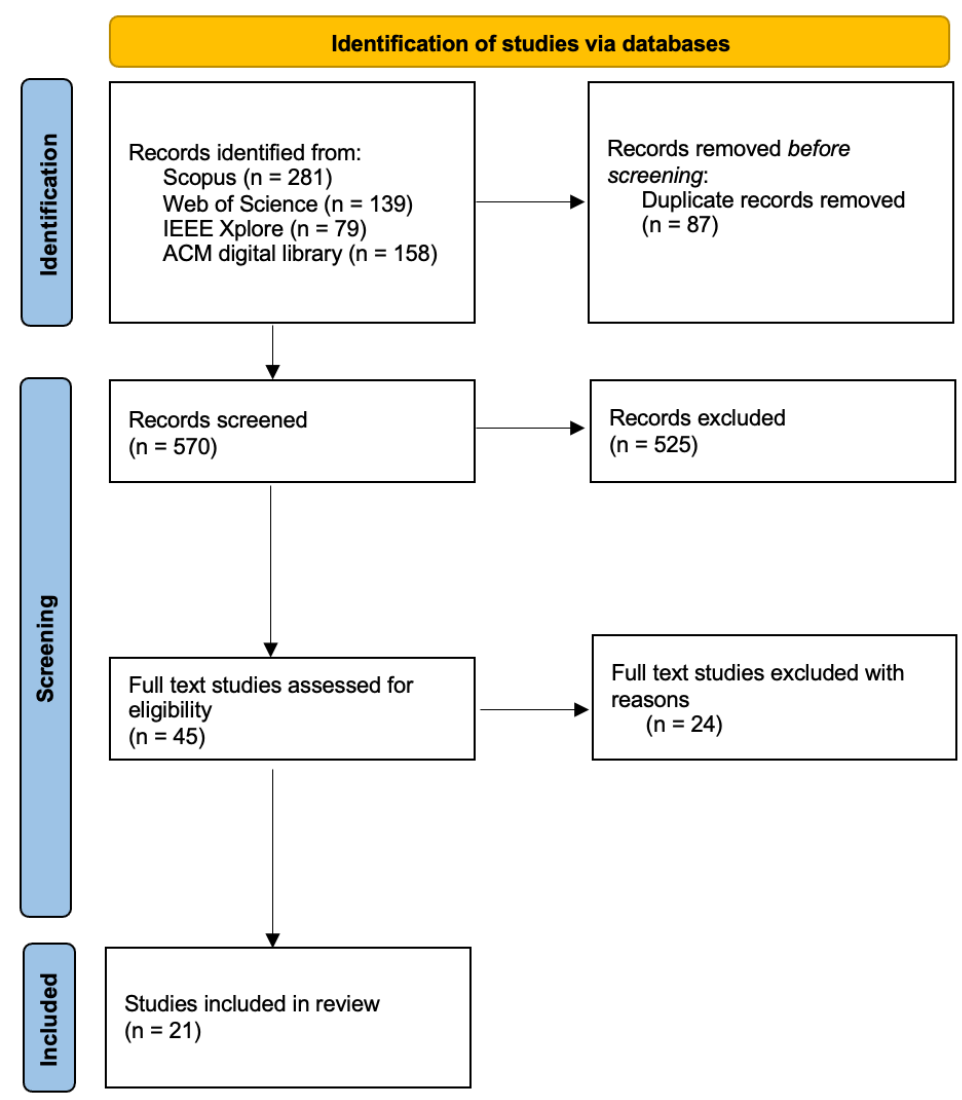
Figure 2. The Preferred Reporting Items for Systematic Reviews and Meta-Analyses (PRISMA) flowchart of this systematic literature review, based on the PRISMA 2020 guideline.